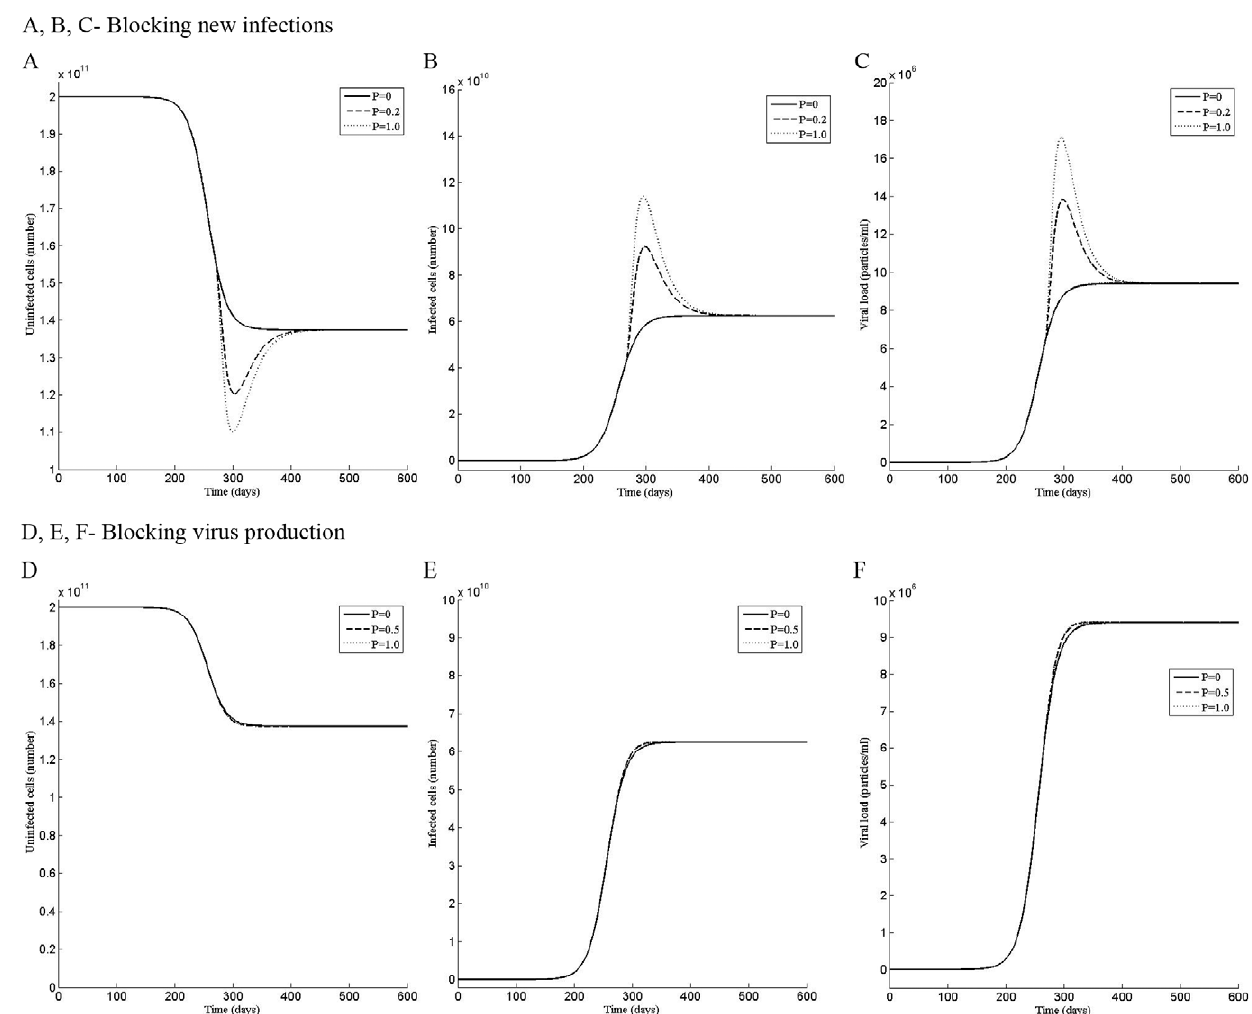
Figure 4. Perturbation in the third phase does not alter the steady state of the infection. Dynamics of the (A) uninfected cells, (B) infected cells, and (C) the viral load when the system was perturbed by the dose P of the drug that blocks new infections during the time period t=270 to t=450 day. Dynamics of the (D) uninfected cells, (E) infected cells, and (F) the viral load when the system was perturbed by the dose P of the drug that blocks virus production during the time period t=270 to t=450